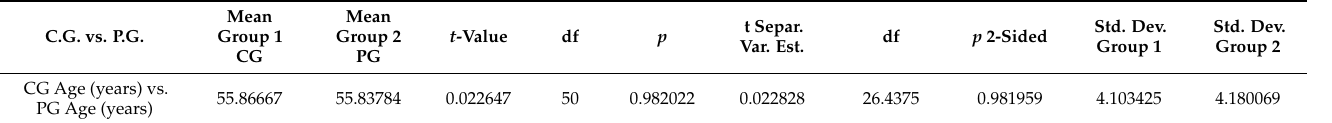
Table 2. Characteristics of the t -test results.